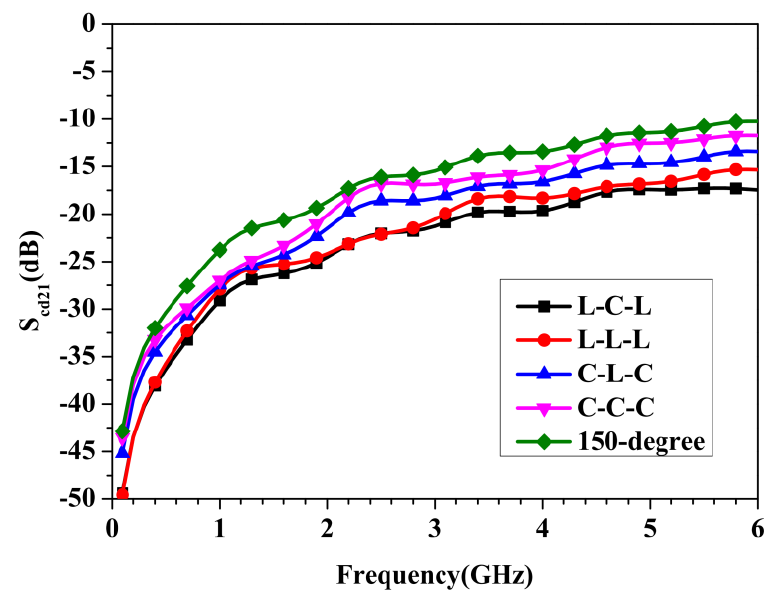
Figure 10. The simulated results of differential-to common-mode conversion loss (Scd21).